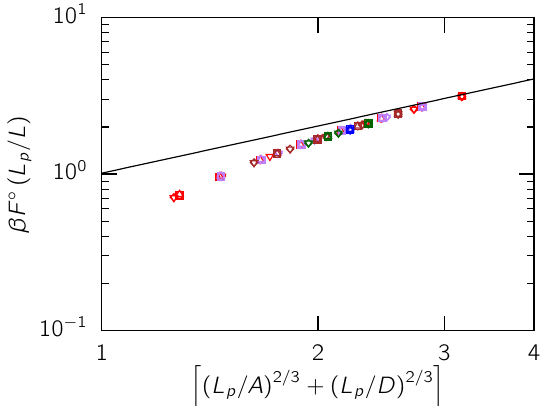
Figure 4. Confinement free energy of ideal chains in various channel sizes. The black solid line is the confinement free energy in the classic Odijk regime valid in the limit D (cid:28) L p and A (cid:28) L p (Equation (4)). The L p / b values for ideal chains shown here are L p / b = 10 ( (cid:3) ), L p / b = 12.5 ( (cid:53) ), L p / b = 15 ( (cid:13) ), L p / b = 17.5 ( (cid:5) ) and L p / b = 20 ( (cid:52) ). Different colors indicate different A / D ratios: red (1), purple (1.5), brown (2), green (3) and blue (4). All the data points satisfy the condition D ≤ A ≤ 2 L p .